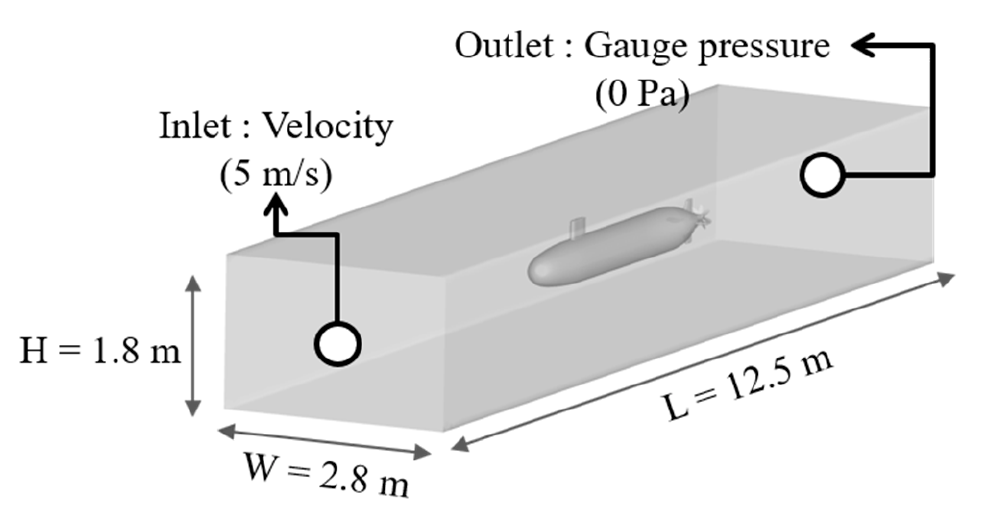
Figure 2. Entire computation domain and boundary conditions with Suboff body and propeller.